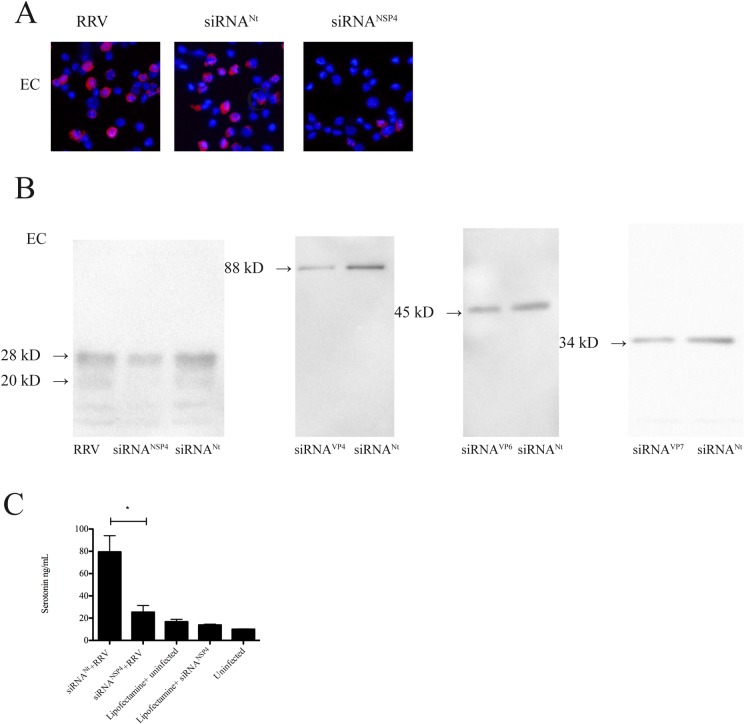
Intracellular expressed NSP4 stimulates serotonin release from human EC tumor cells.(A) EC tumor cells were transfected with siRNANSP4. At 24 h p.i cells were infected with RRV at a MOI of 0.5 and after 7 h p.i cells were harvested and stained for NSP4 by a rabbit anti- NSP4 and a rhodamine-conjugated goat anti-rabbit (red) conjugate. (B) Silencing effect on NSP4, VP4, VP6 and VP7 expression in EC tumor cells. Following transfection and infection, cells were lysed and viral protein expression analysed by western blotting. With every western blot analysis, the amount of loaded protein was adjusted by comparing protein content in Comassie Blue-stained gels. 28 kD = glycosylated form of NSP4, 20 kD = non-glycosylated form of NSP4. (C) EC tumor cells transfected with siRNANSP4 and infected. At 7 h p.i medium was changed and after 1 h supernatants were collected and analysed for serotonin. * = p ˂ 0.05 with Mann-Whitney U test; n = 4.